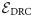
Comparison of the results from the distributed DRC algorithm and the original sequential implementation [15] on 25 2D images from the Berkeley benchmark database [37].(a) Histogram of the maximum energy difference occurring anywhere along the energy evolution path; EDRC is the sequential algorithm and EN the distributed algorithm on N computers. (b) Histogram of the final energy difference of the converged solutions. (c) Histogram of the difference in the total number of iterations required to reach the converged final solution.